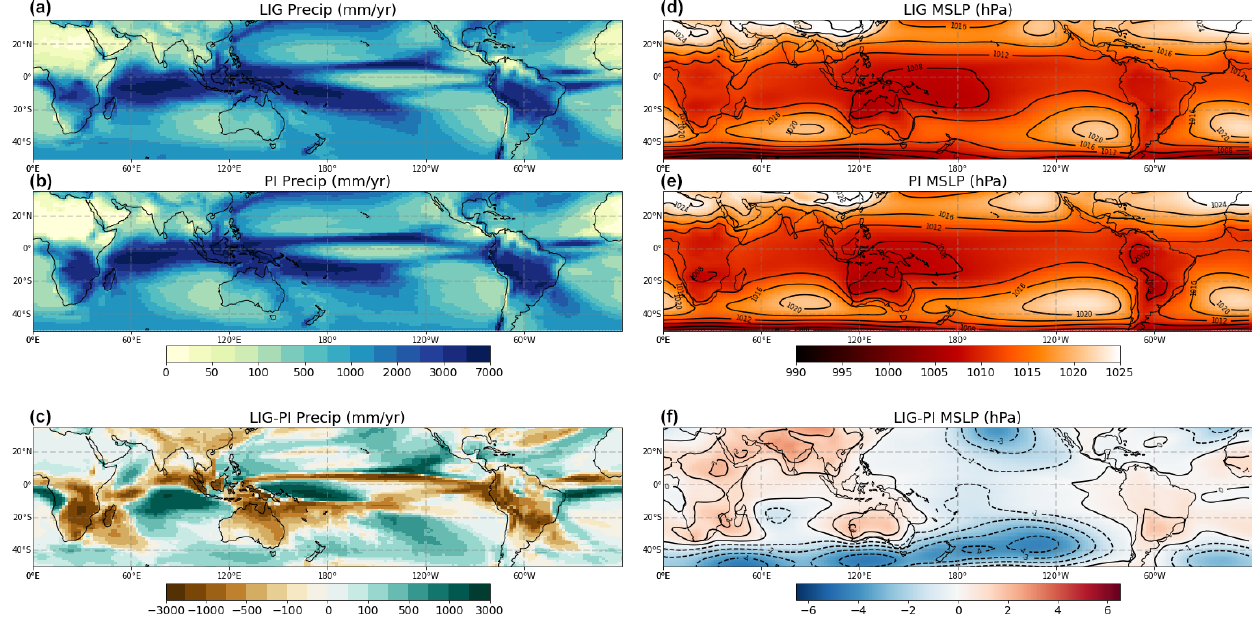
Figure 4. Left panels: simulated DJF precipitation for (a) LIG, (b) PI and (c) LIG minus PI. Right panels: simulated DJF mean sea level pressure (MSLP) for (d) LIG, (e) PI and (f) LIG minus